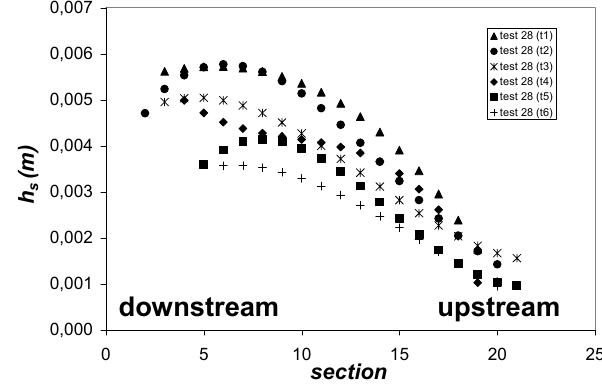
Fig. 12. Example of evolution in time (picture time t 1 , t 2 , ... ) of moving layer thickness, h s , increasing from upstream to down- stream. For a fixed section, h s decreases in time, following the sediment discharge trend (see Fig. 7).